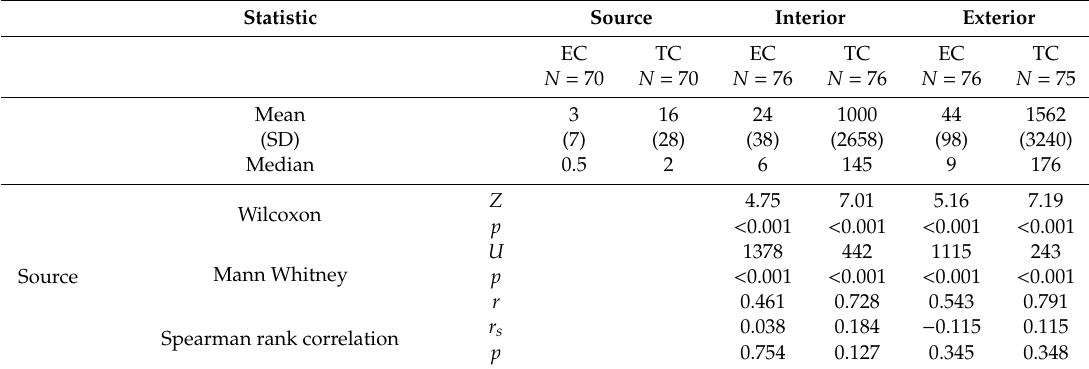
Table 4. Bivariate comparisons of E. coli (EC) and total coliform (TC) concentrations (in CFU / 100 mL) by point of collection using Wilcoxon signed rank (related samples), Mann-Whitney U (unpaired data) and Spearman’s rank-order correlation